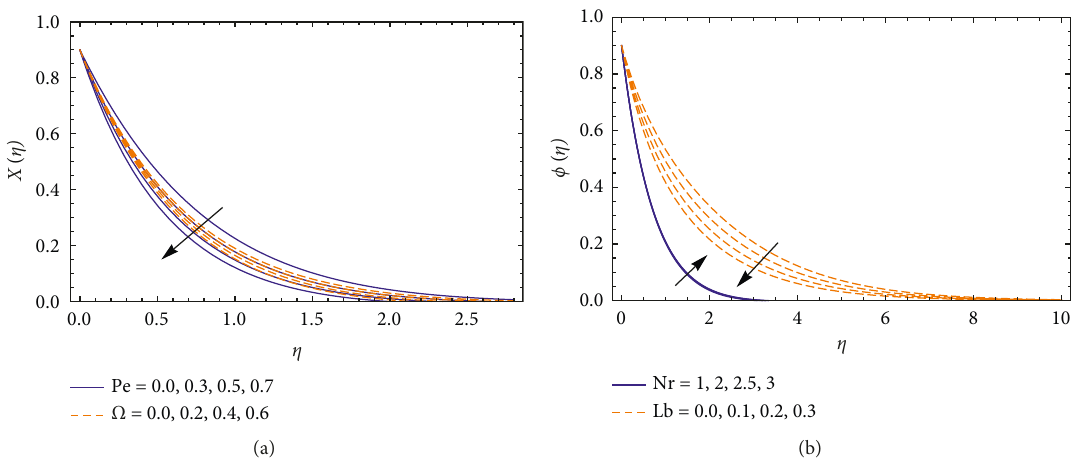
Figure 5: Microorganism profile for different values of P